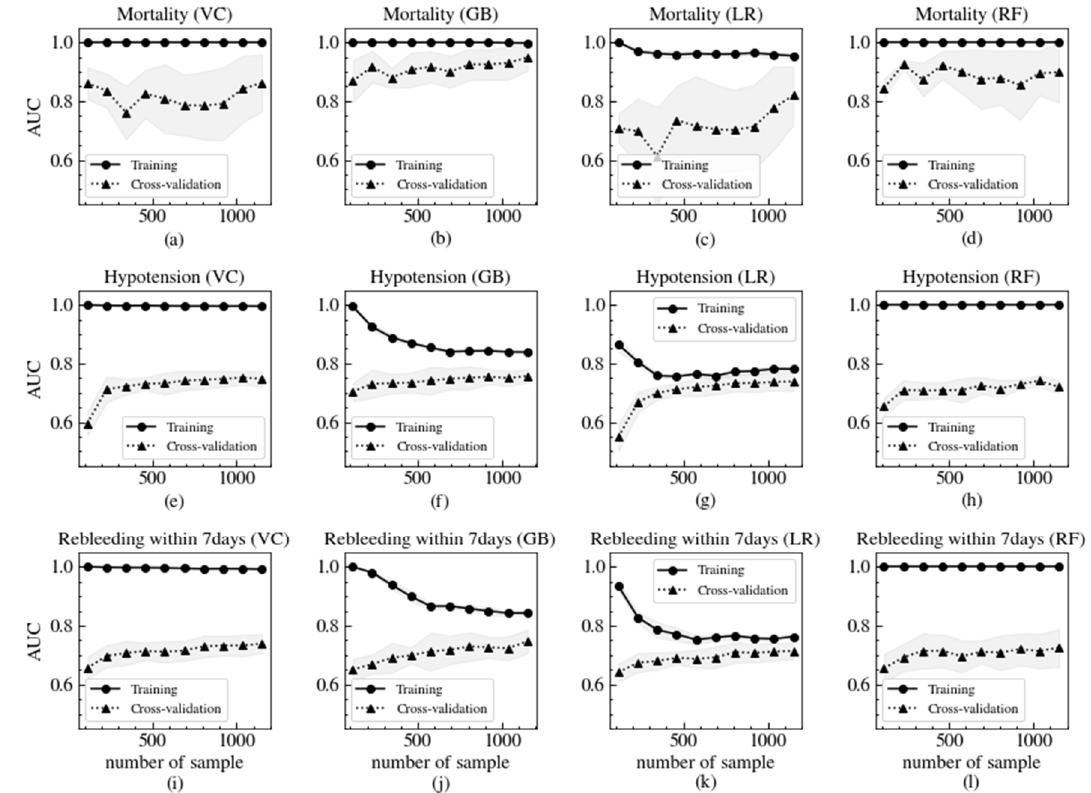
Figure 2. According to the number of sample, the AUC learning curves of VC ( a ), GB ( b ), LR ( c ) and RF ( d ) for mortality. When the outcome is hypotension, ( e ), ( f ), ( g ) and ( h ) are the AUC learning curves as a function of the number of samples of VC, GB, LR and RF respectively. The AUC learning curves of VC, GB, LR and RF for rebleeding within 7 days are shown in ( i ), ( j ), ( k ) and ( l ) respectively. Circles and solid lines symbolize the learning curve of the mean AUC for the training data-set. Triangles and dotted lines represent the learning curve of the mean AUC for the test data-set. The 1 standard deviation ranges are shown in the shaded region of the markers and line types.